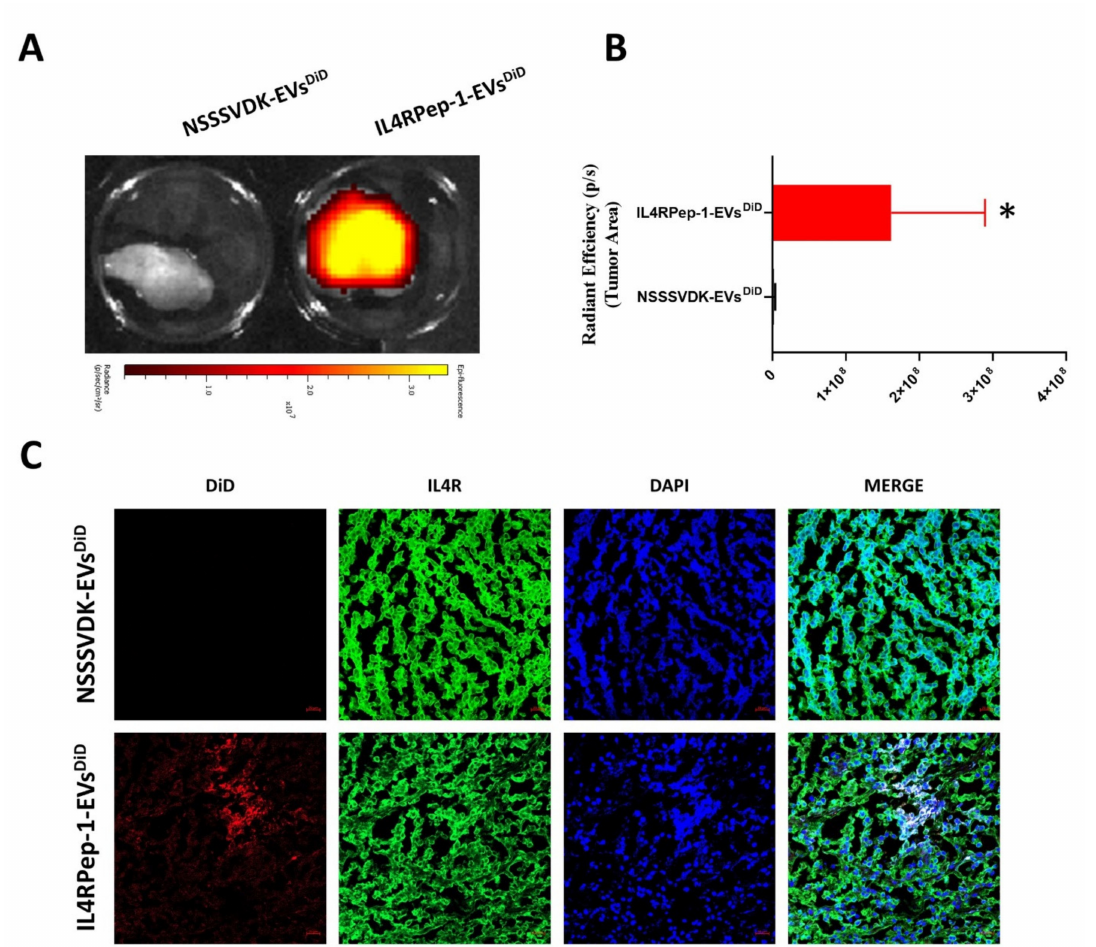
Figure 7. Ex vivo fluorescent and microscopic imaging of IL4R Pep-1 extracellular vesicles (EVs) in Cal-62 tumors in mice. ( A ) Ex vivo fluorescent imaging of intravenously (i.v.) injected NSSSVDK- EV DiD and IL4RPep-1-EV DiD in Cal-62 tumor-bearing mice. ( B ) Quantification of florescent signals present in the ex vivo tumors (n = 3) represented in ( A ). ( C ) Immunofluorescent imaging of DiD (red) and IL4R (green) in sectioned tumor (scale bar: 20 µ m). Data are represented as means ± standard deviations. Statistical difference between groups was analyzed using Student’s t -test. * p <